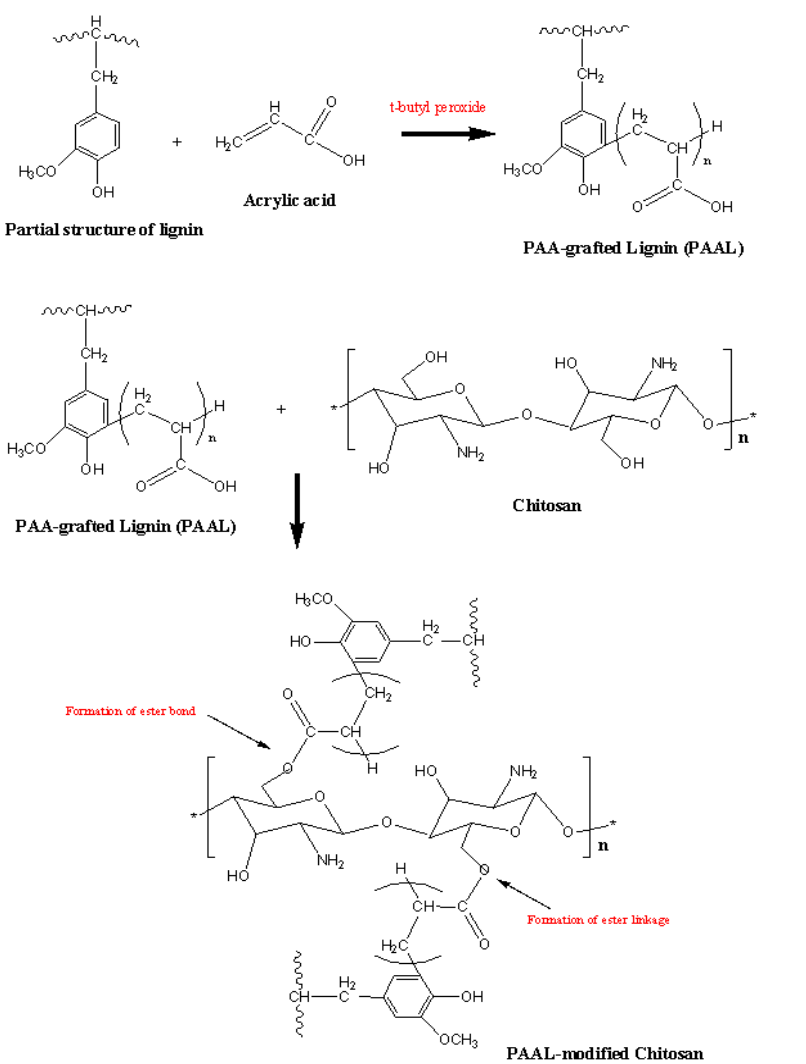
Figure 2. A possible schematic grafting reaction between OSL and acrylic acid, and the chemical modification of chitosan fiber.